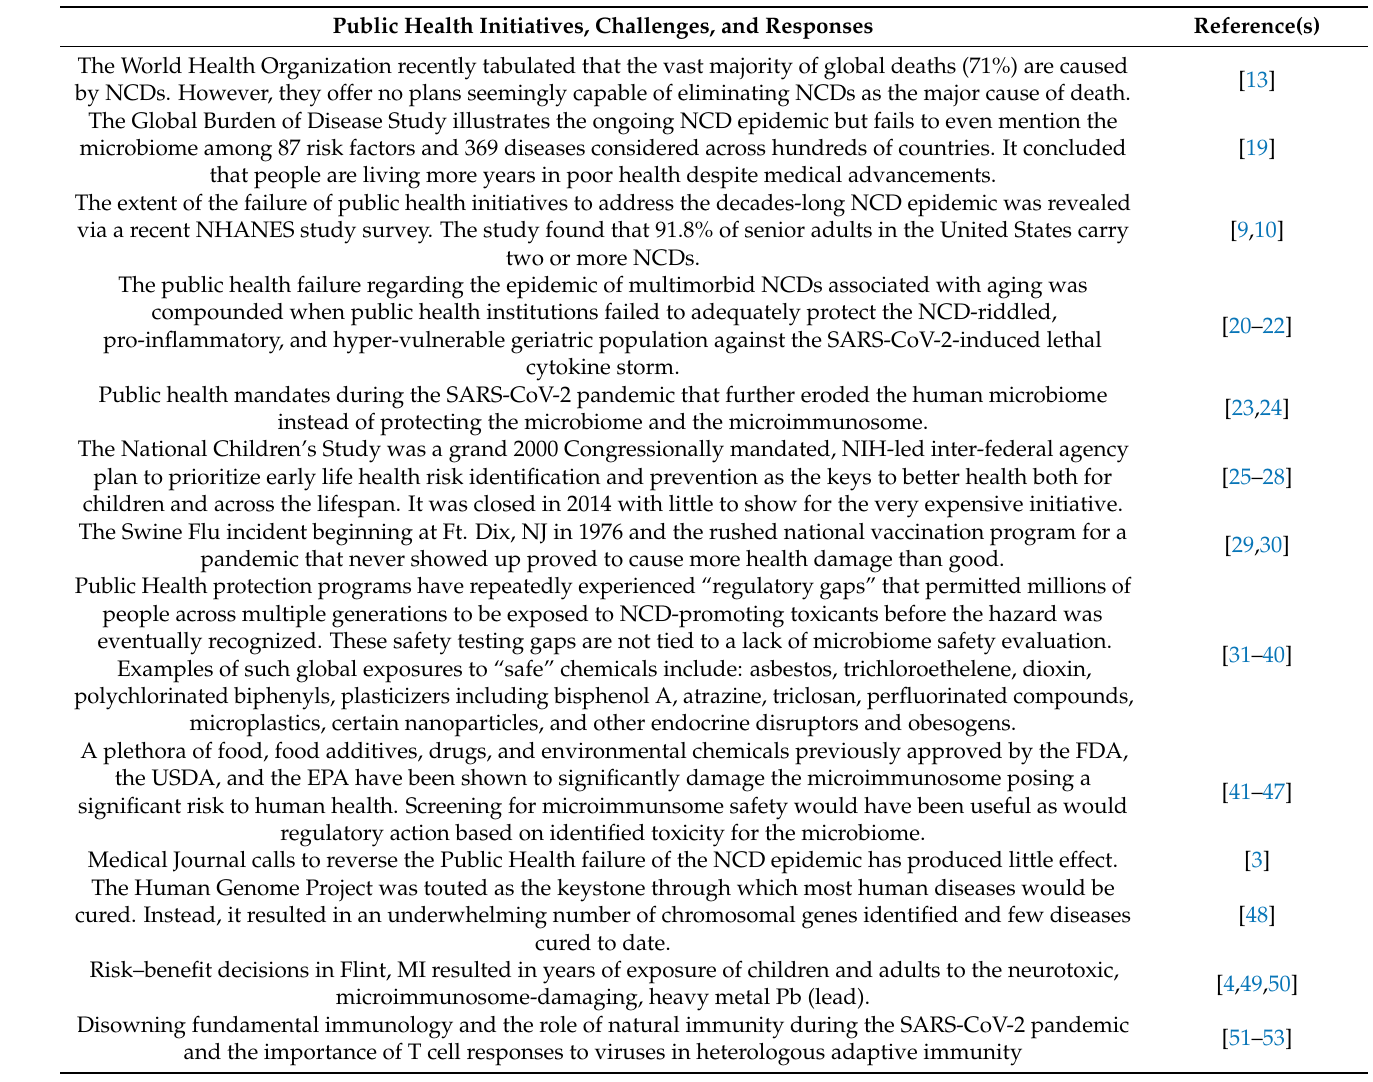
Table 1. Thirteen Examples Reflecting Outcome-Based Failures of Public Health and/or Major Public Health Initiatives that Produced Underwhelming